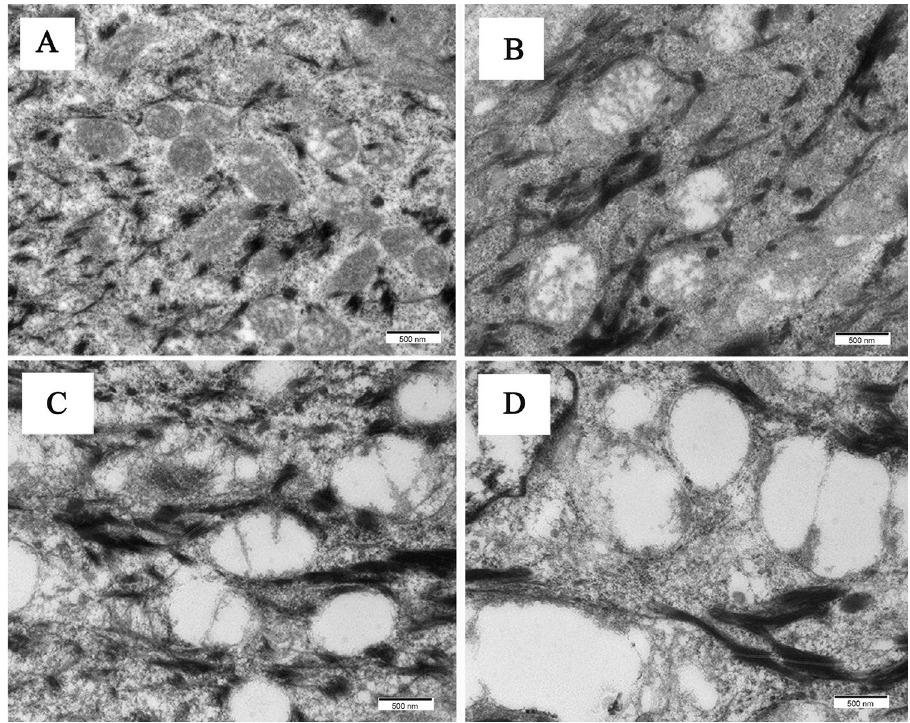
Figure 1. Semiquantitative scale of mitochondria injury degree. ( A ) scale 0, no damage; ( B ) scale 1, minimal damage; ( C ) scale 2, moderate damage; ( D ) scale 3, heavy damage.